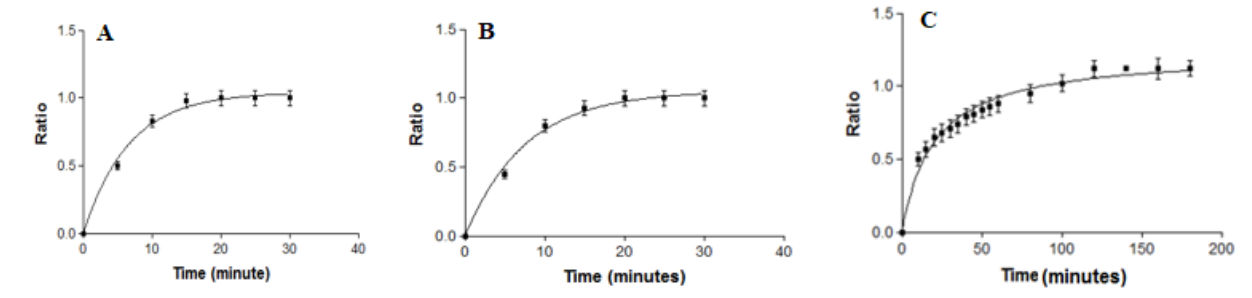
Figure 5. Swelling ratio versus time of Donepezil formulations ( A ) DPZ-PGel 1 , ( B ) DPZ-PGel 2 , ( C ) DPZ-CGel.